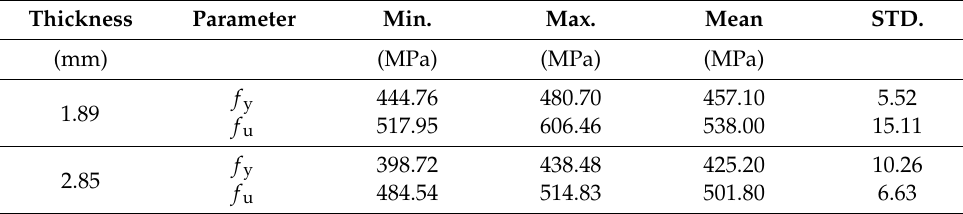
Table 1. Parameters of cold-rolled steel of class S350 GD from tensile tests.